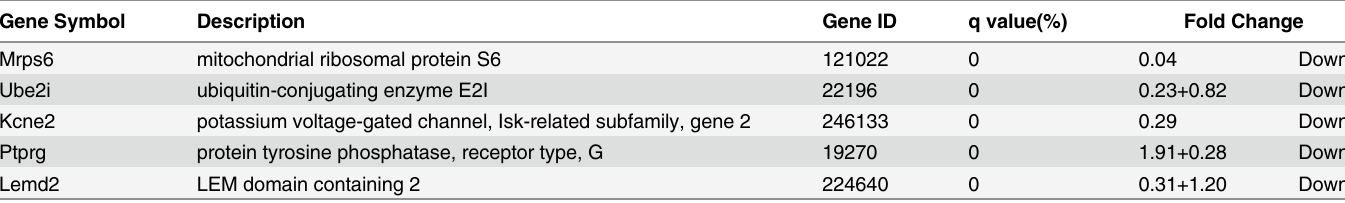
Table 5. Differentially expressed genes in KTL vs WTL group.